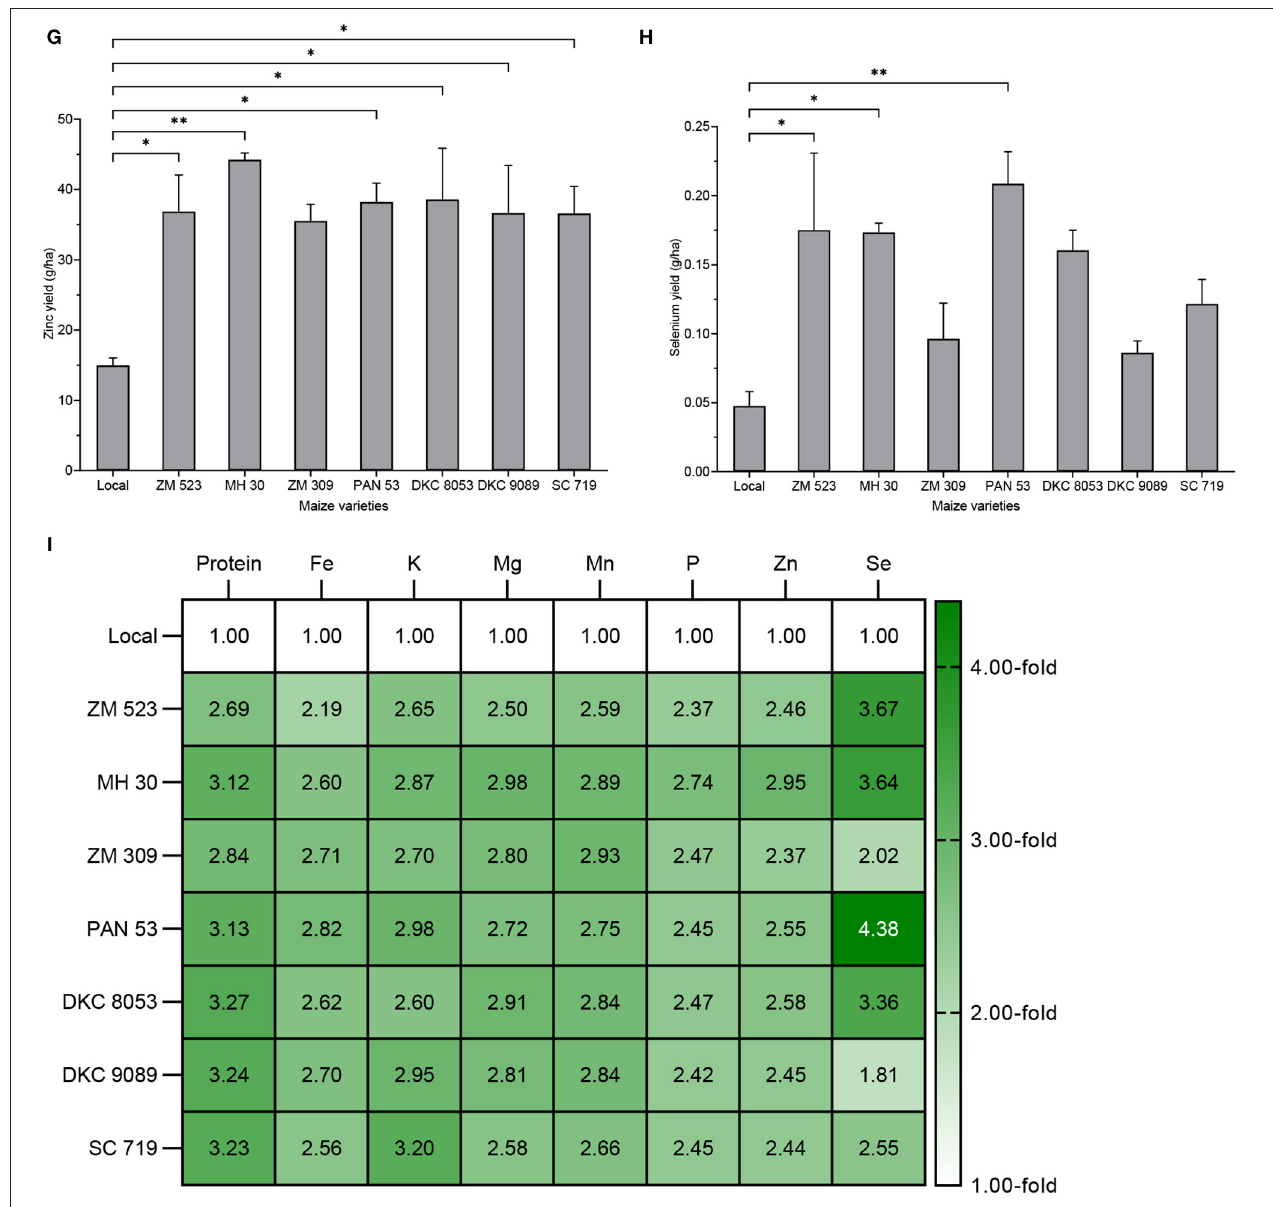
FIGURE 3 | Nutrient yield of eight maize varieties grown in Malawi. Error bars represent SEM. *, **, and *** mean, significant at 0.05, 0.01, and 0.001, respectively, Tukey’s HSD test. Values in plate (F) are the number of fold-change compared to local